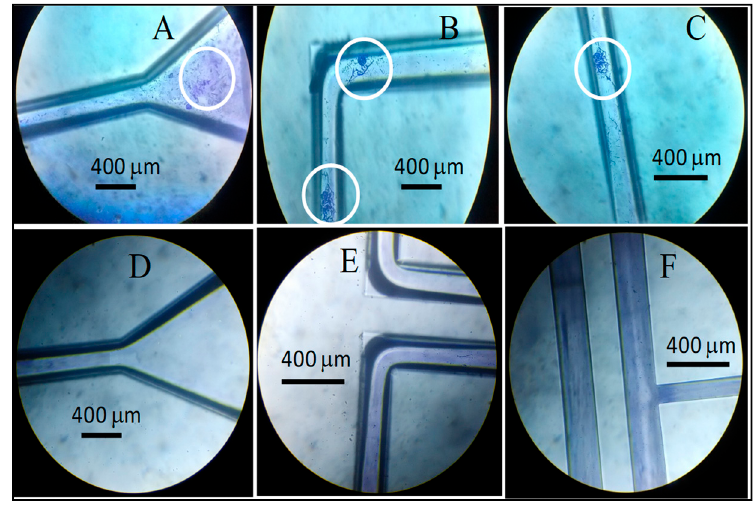
Figure 8. Optical microscopic images of microfluidics (MF) assembly and biofilms. MF channels with (Test-Lower row D – F ) and without (Control-Upper row A – C ) biosurfactant (BS) coatings (625 µg/mL). In absence of biosurfactant (BS) coating, no inhibition of adhesion and therefore confluent biofilm formed by B. subtilis MTCC 2423 ( A – C ). White coloured circles indicates the biofilm stained with crystal violet (1%) solution. In contrast, the test MF channels ( D – F ) are seen clear without biofilms.